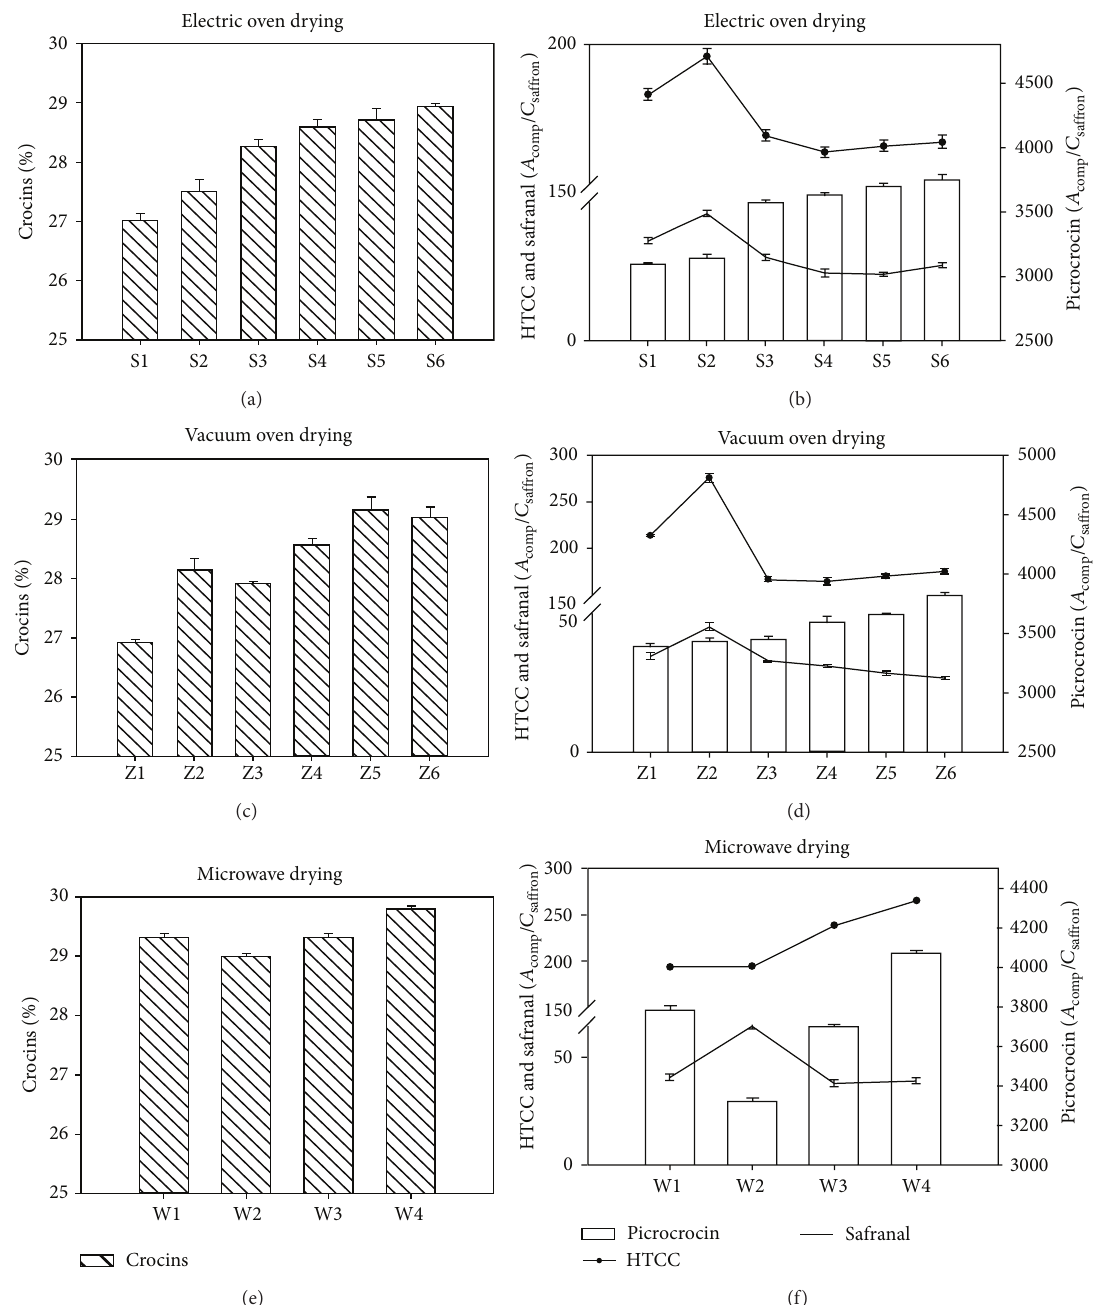
Figure 3: The crocin, safranal, and picrocrocin quantities in saffron dried by different